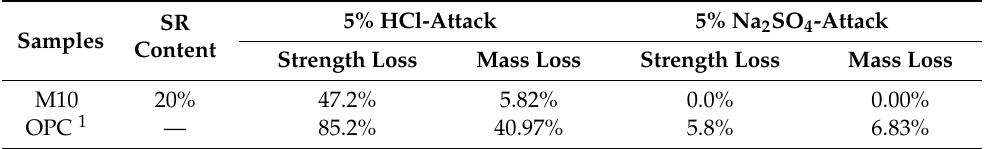
Table 7. The compressive strength and mass losses of M10 (cured for 360 d) and Ordinary Portland